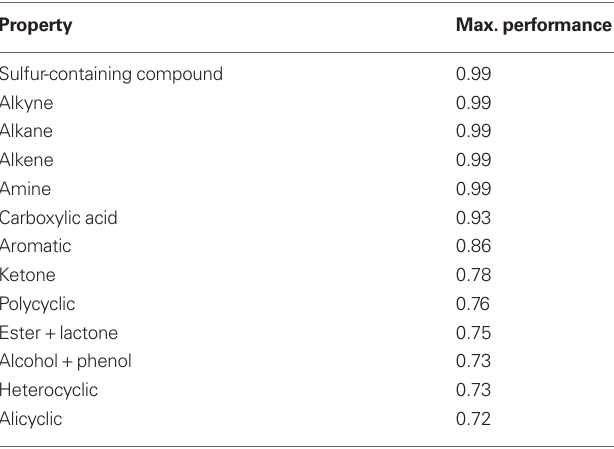
Table 2 | Classification performance of odorant